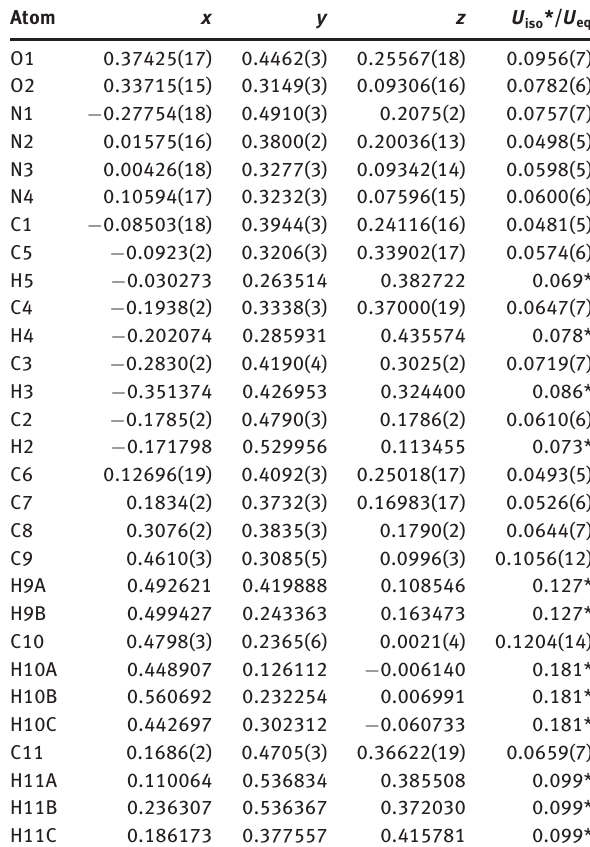
Table 2: Fractional atomic coordinates and isotropic or equivalent isotropic displacement parameters (Å 2